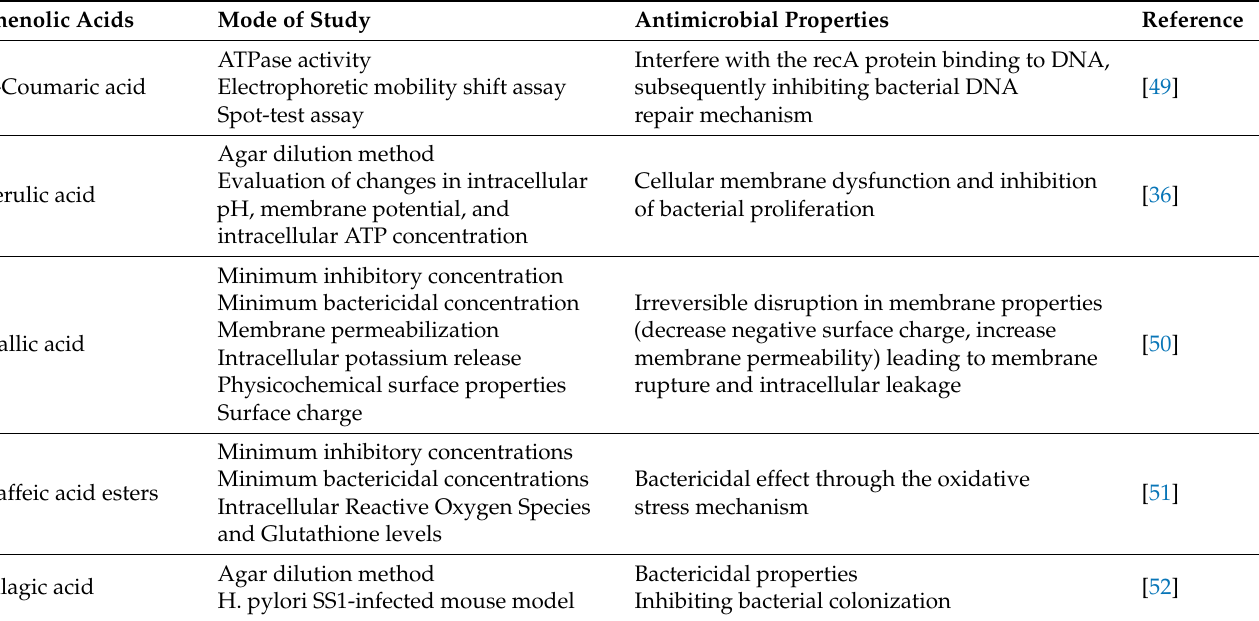
Table 4. Common phenolic acids found in honey and their antibacterial